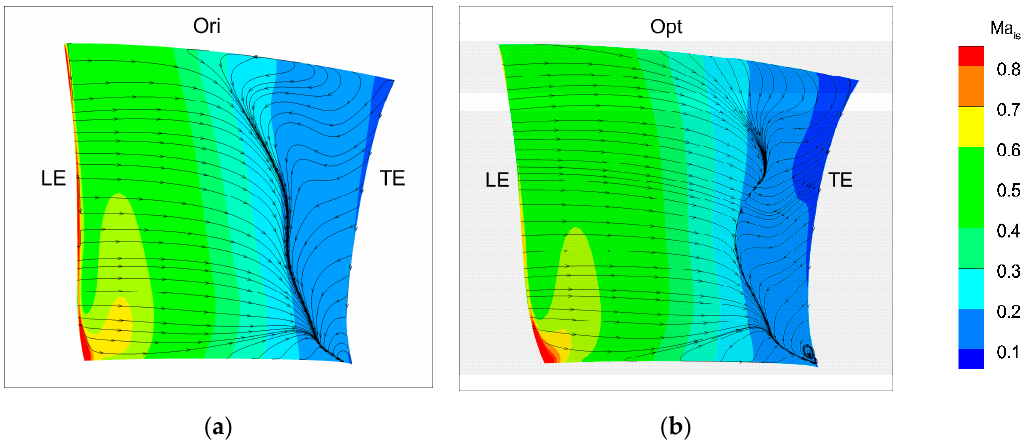
Figure 20. Limiting streamline on the suction surface of the second-stage stator for original and optimized compressor. ( a ) Limiting streamline on the suction surface for original compressor; ( b ) limiting streamline on the suction surface for optimized compressor.